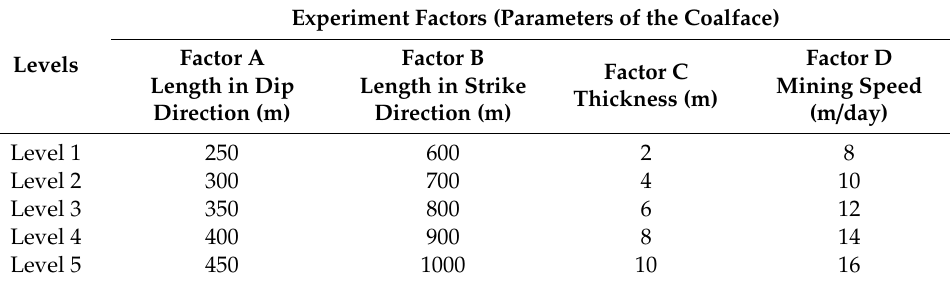
Table 1. Selection of factors and levels for the orthogonal experiment.